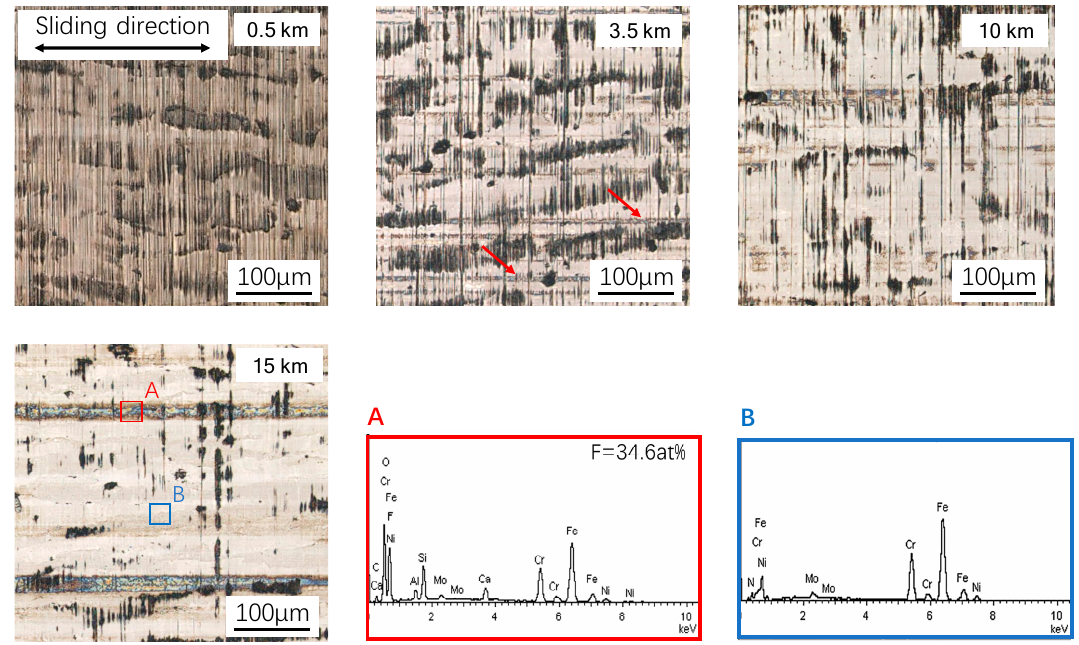
Figure 9. The typical confocal laser scanning microscopy (CLSM) images of the counter-part surface showing the transfer film development at 100 °C, and the chemical composition after 15 km sliding.